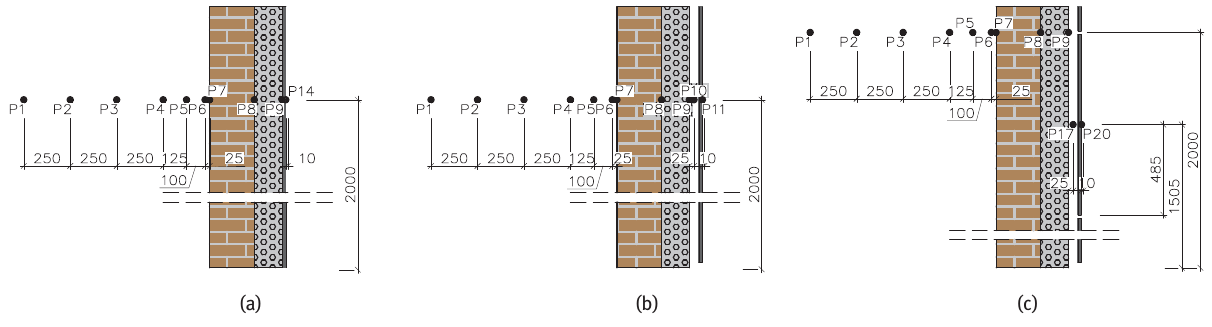
Figure 7: Location of temperature measurement points: (a) standard facade, (b) closed-joint ventilated facade and (c) open-joint ventilated facade.